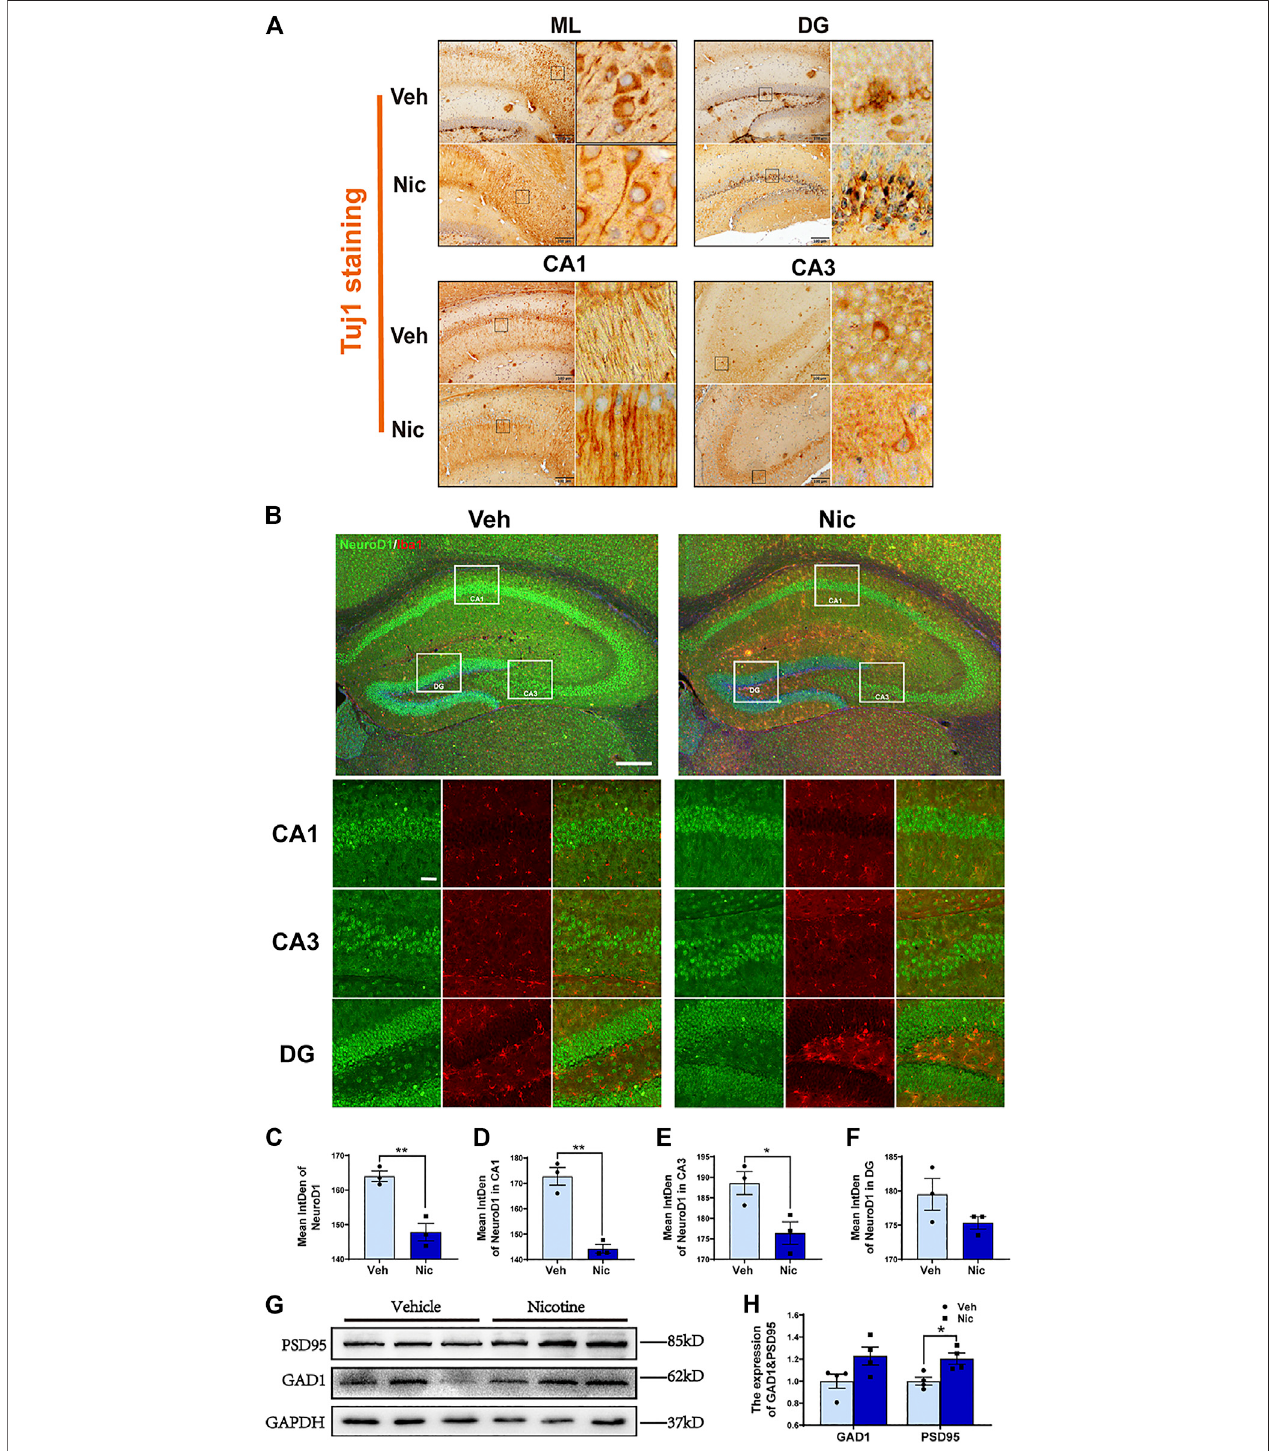
FIGURE 7 | Maternal nicotine exposure promotedelongationofaxons and expressionofthe synaptic-associated proteinin offspring. (A) Maternalnicotine exposure promoted elongation of axons in ML, DG and CA1, but did not affect on axonal prolongation in CA3. (B) NeuroD1-positive cells in the offspring ’ hippocampi were analyzedbyimmuno fl uorescencestaining.Representativeimageswereshown. (C) Thequanti fi cationof fl uorescenceintensitybyImageJshowedthattheimmuno fl uorescence intensityofNeuroD1decreasedobviouslyinthehippocampusofthenicotinegroup,includinginCA1 (D) andCA3 (E) notinDG (F) . (G) Westernblotanalysisoftheactivation of PSD95 and GAD1 in the hippocampus of the offspring. (H) PSD95 protein level was increased in nicotine offspring as compared to vehicle offspring. There is no difference in GAD1 between nicotine and vehicle treatment. * p < 0.05, ** p < 0.01; Scale bar:200 μ m (A); 200 μ m (low power lens), 50 μ m (high power lens) (B). all data are means ± SEM.